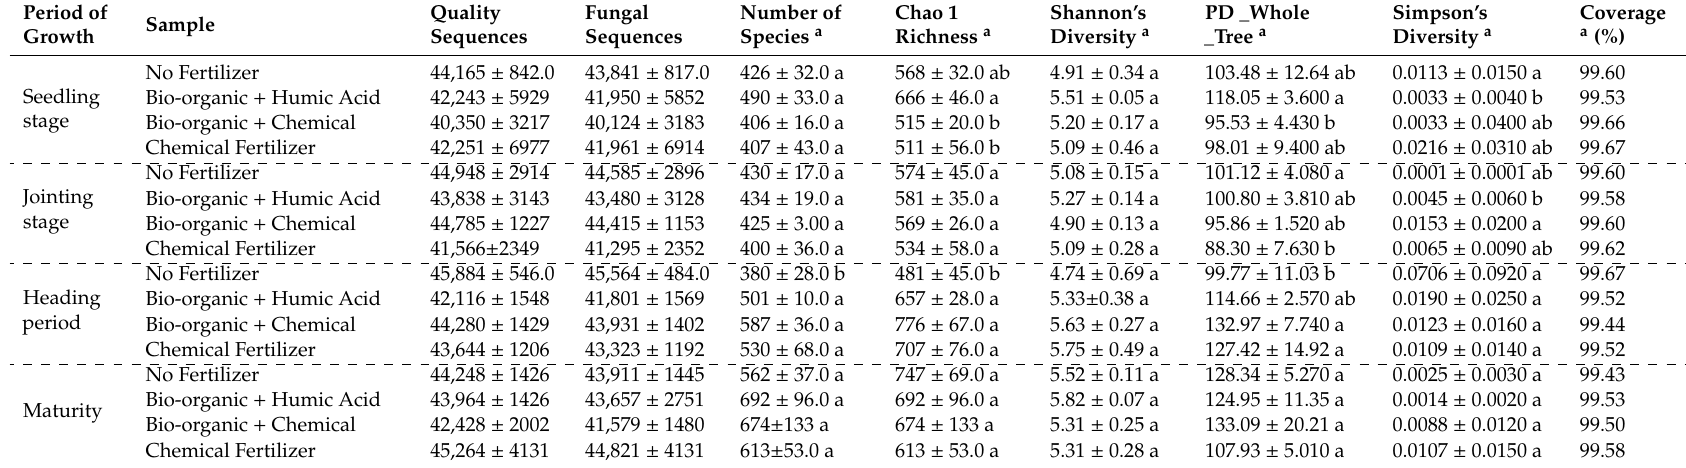
Table 1. Illumina Mi-Seq sequenced fungal data and fungal community diversity indices (at 97% sequence similarity) based on the ITS nrRNA